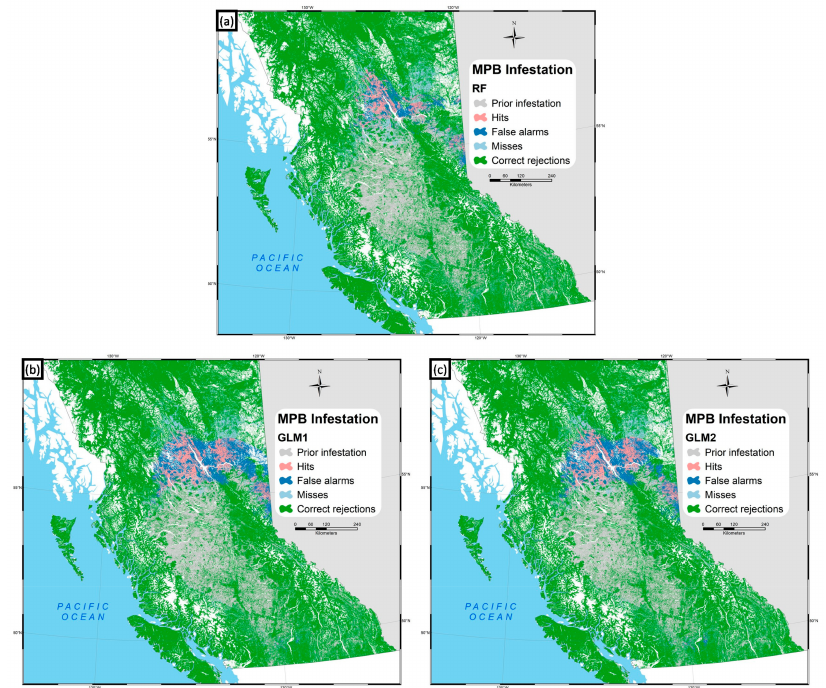
Figure 4. Validation analysis by comparison of simulated and observed changes in study area from 2008 to 2014. White color indicates no data. Algorithms: ( a ) RF, ( b ) GLM1, ( c ) GLM2. Hits are correct simulations of change. False alarm errors are persistence simulated as change. Miss errors are change simulated as persistence. Correct rejections are correct simulations of persistence. Infestations prior to the study are excluded from the study